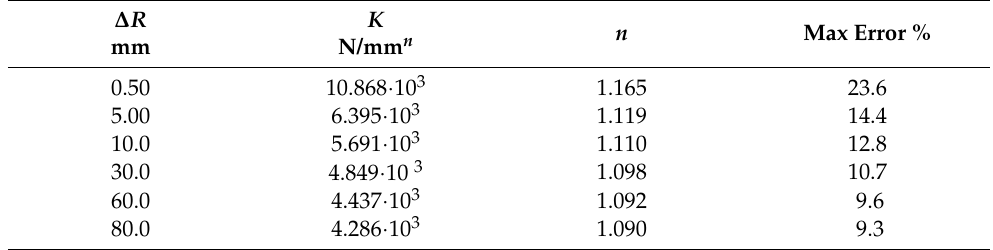
Table 9. Polynomial version of the EDSU-78035 [36] contact force model